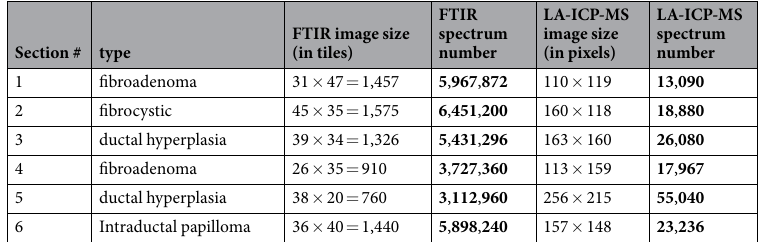
Table 1. Characteristics of the images analyzed in this work. One FTIR tile corresponds to 4096 pixels or 4096